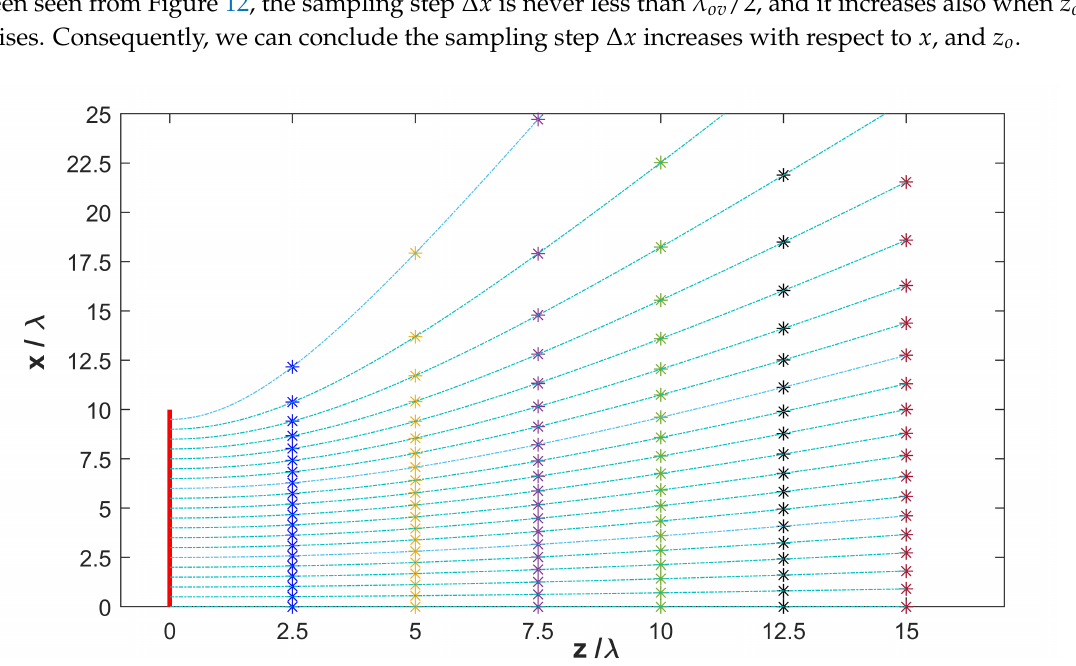
Figure 11. Position of the sampling points { x m } for different values of z o when χ = 1.